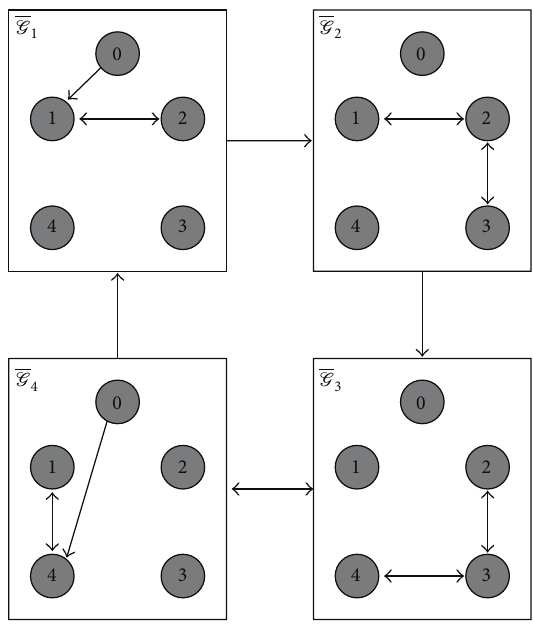
Figure 1: The switching network